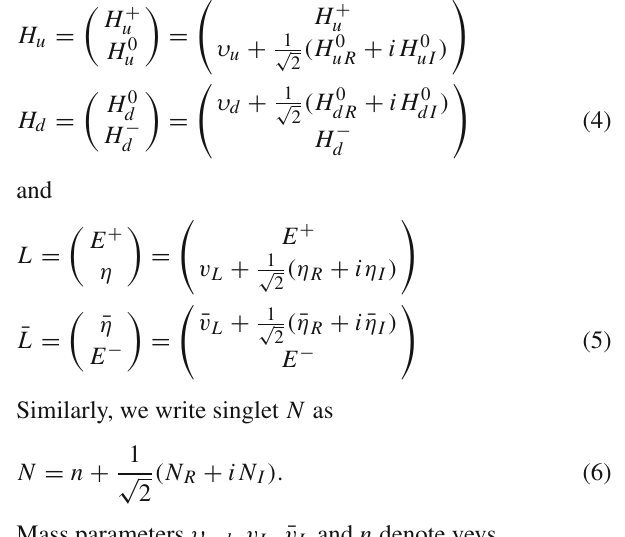
Table 1 TeV-scale VL models and their representations under SU ( 5 ) VL model